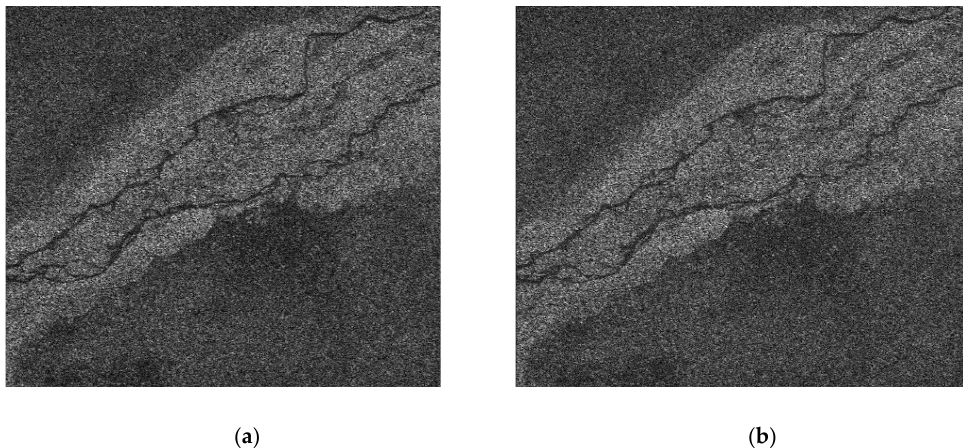
17 of 20 Figure 18. FPGA processing single point results. Table 5. Result of the single point. Peak Sidelobe Ratio (PSLR) (dB) Integral Sidelobe Ratio (ISLR) (dB) Impulse Response 3dB Width (IRW) −1 3.05 −9 .21 1.05 From hardware test results on the target point, we see that the BP hardware imple- mentation presented in this paper meets the design expectations.